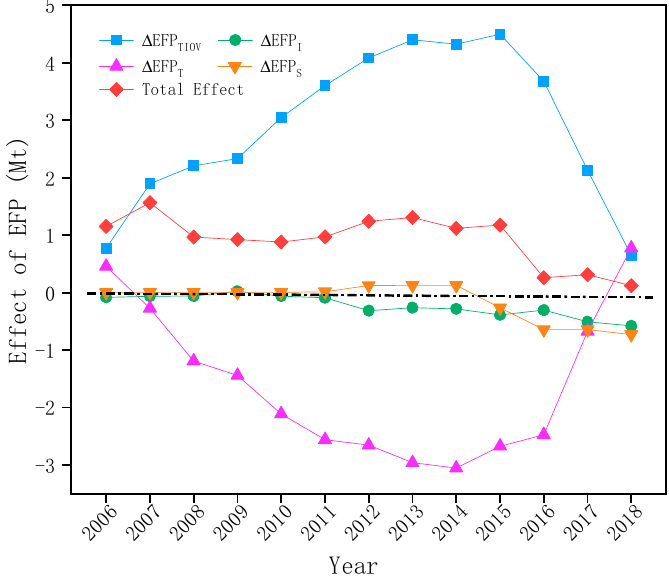
Figure 3. EFP e ff ect decomposition of Shaoxing’s textile industry during Figure 3. EFP effect decomposition of Shaoxing’s textile industry during 2006–2018.